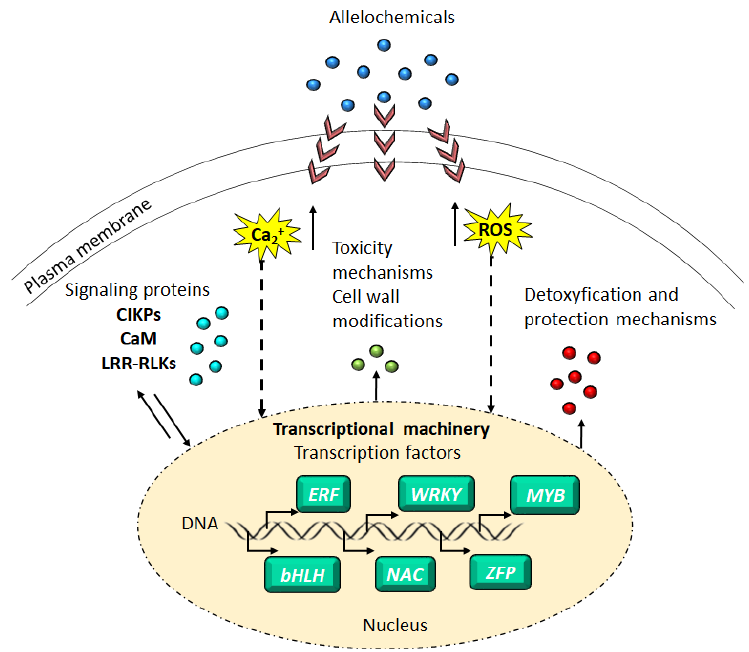
Figure 3. Molecular model of Conyza canadensis allelopathic effect proposed by Zhang et al. [36], illustrating the signaling machinery, the transcriptional regulation, and the cellular processes involved in stress response in Arabidopsis thaliana roots.